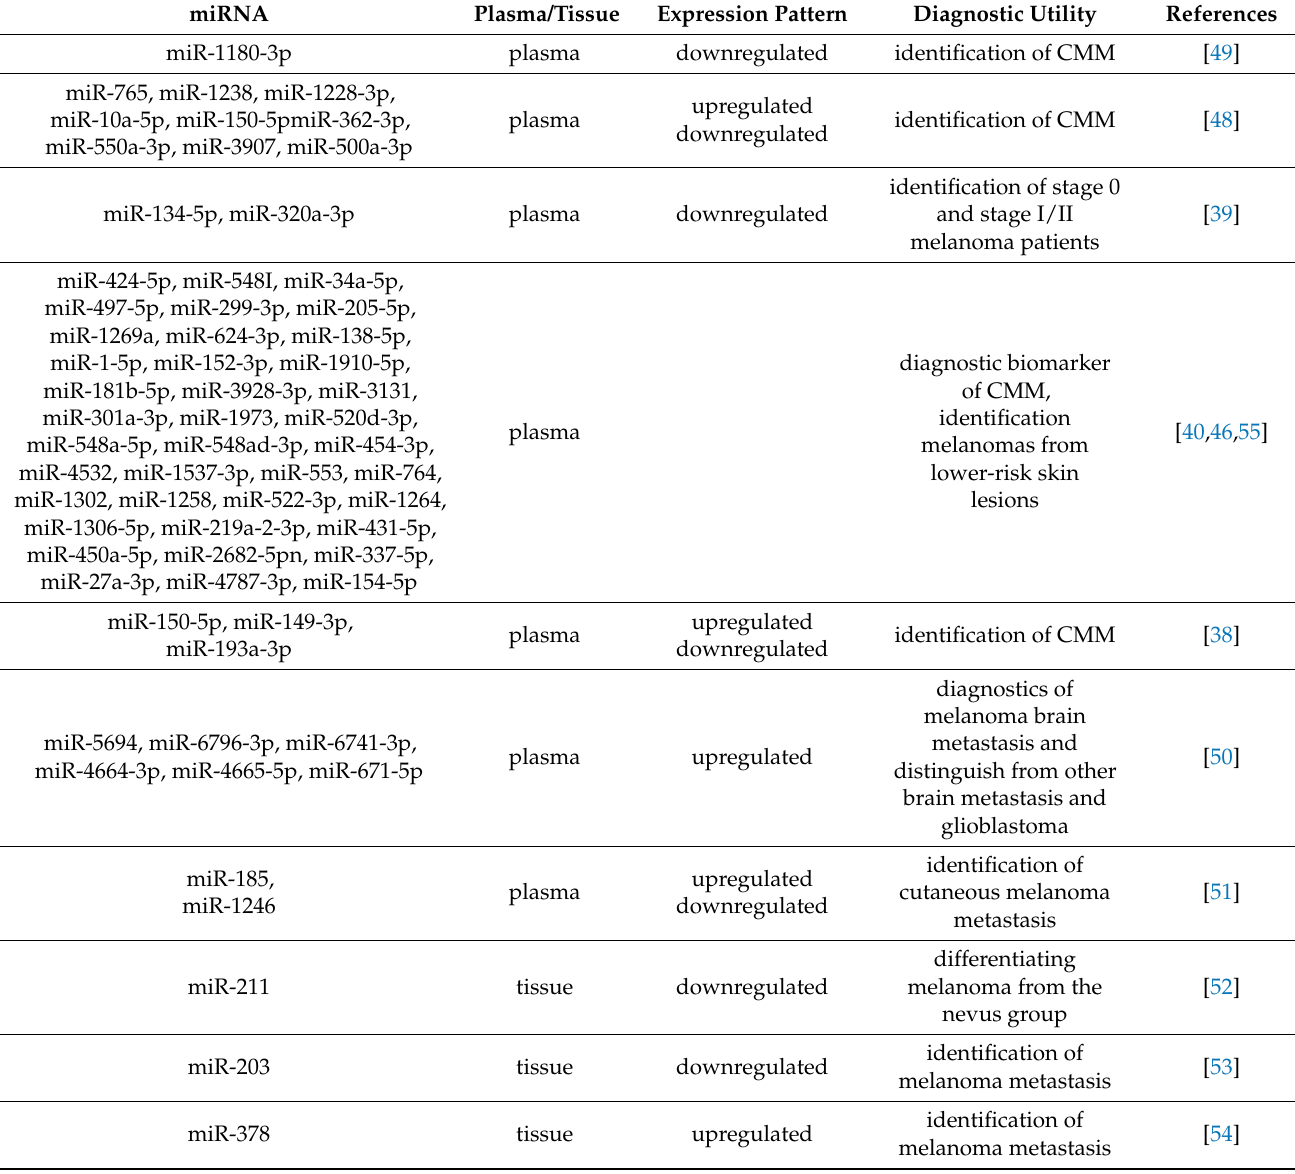
Table 1. Plasma and tissue microRNAs as diagnostic biomarkers for cutaneous malignant melanoma